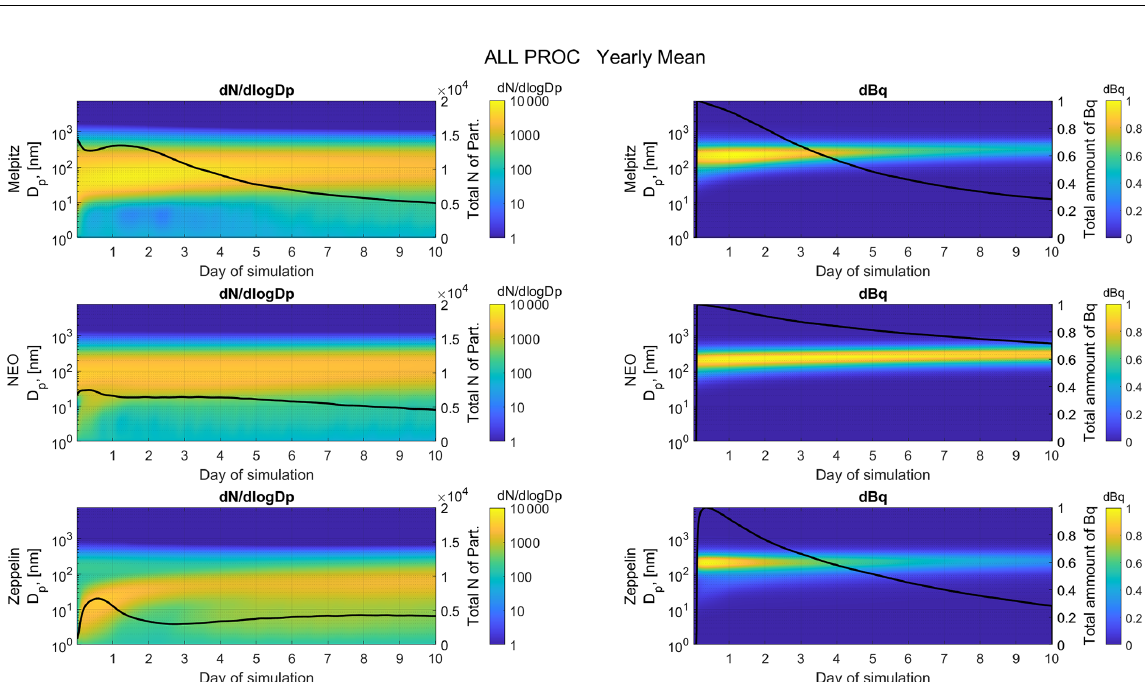
Figure 4. Evolution of the PNSD, d N/ dlog D p (left column) and Becquerel size distribution (right column) for the experiment when all processes are turned on (ALL PROC, annual mean). Black lines are the total number of particles and the total amount of 137 Cs in the respective graph (right-hand axes). Calculations from Melpitz, NEO and Zeppelin in the top, middle and bottom row, respectively.